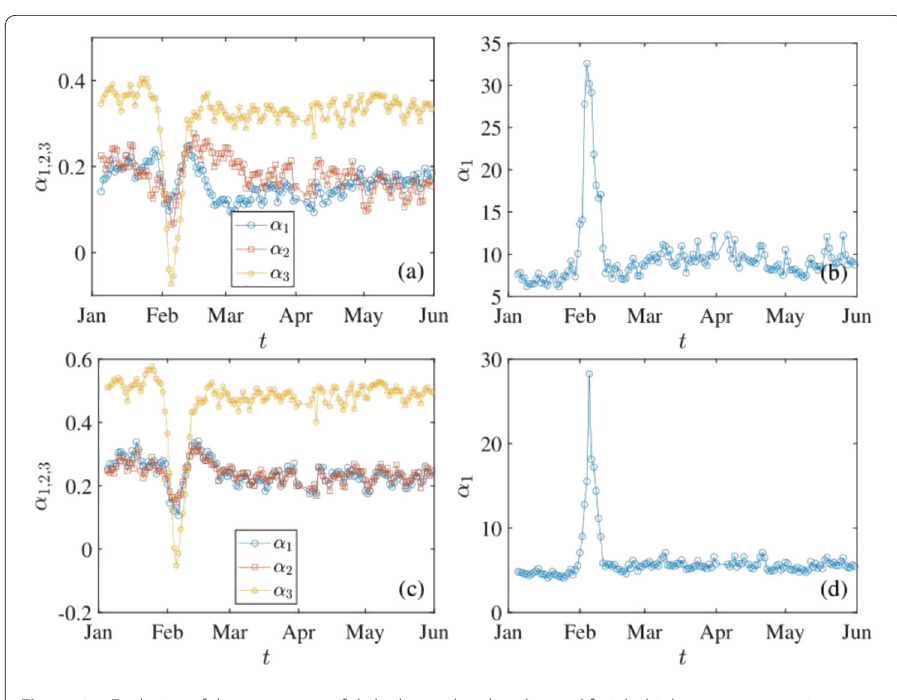
Figure 21 Evolution of the exponents of daily directed and undirected freight highway transportation networks. ( a ) Scatter data of F ij with respect to ( G i / P i ) α 1 ( G j / P j ) α 2 / d α 3 ij for the directed network. ( c ) Scatter data of W ij with respect to ( G i / P i ) α 1 ( G j / P j ) α 2 / d α 3 ij for the undirected network. ( d ) Binning data of W ij with respect to ( G i / P i ) α 1 ( G j / P j ) α 2 / d α 3 ij for the undirected